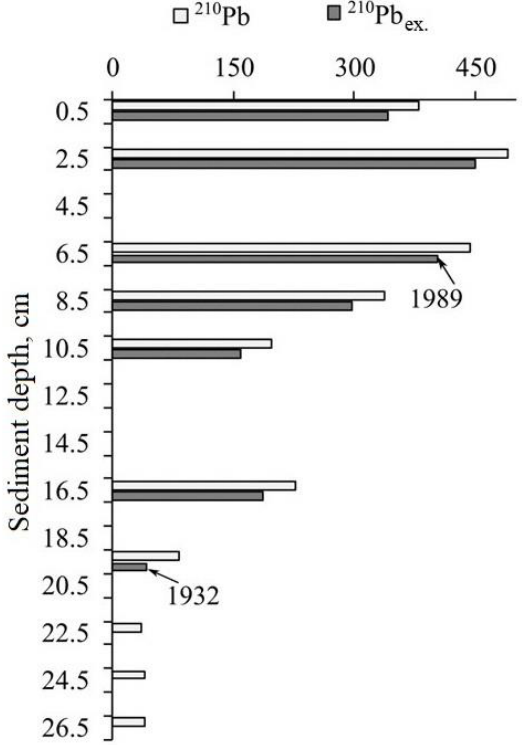
Figure 2. Contents of 210 Pb and 210 Pb ex. (Bq/kg) in separate layers of the sediment core from Lake Bolshoy Vudjavr with indication when the individual layers were formed, calculated from the average sedimentation rate.